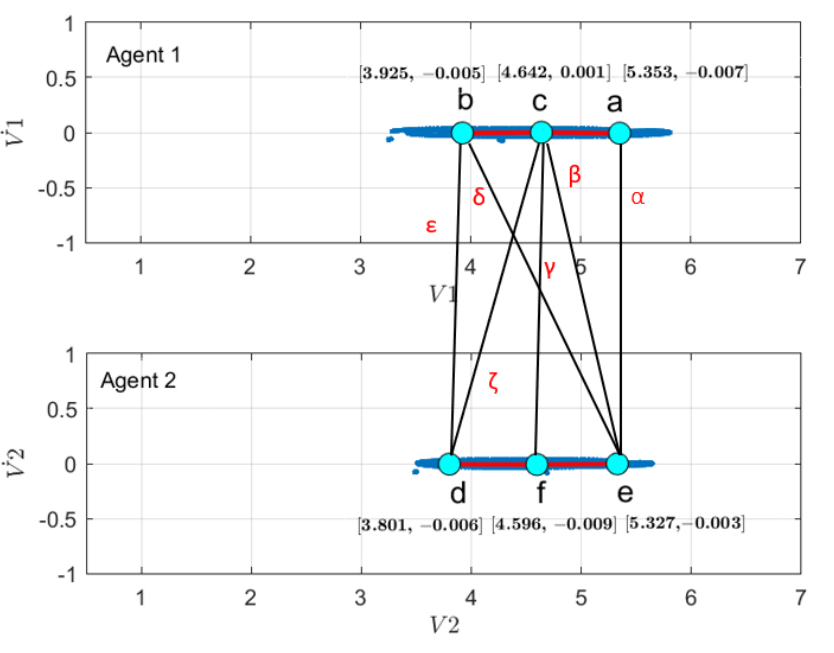
Figure 13. Joint vocabulary from the initial model corresponds to the coupled Bayesian network in the model (orange shaded area in Figure 2). Table 1. Activated node pairs (labels) and values.